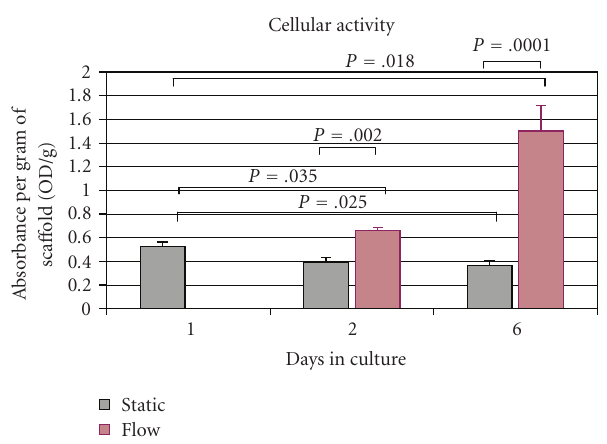
Figure 5: Cellular activity in static and flow-perfusion culture. MTT assay demonstrates no significant change in static culture at day 2. However, metabolic activity increased significantly in cells in flow-perfusion at days 2 and 6. Metabolic activity also significantly decreased in static culture at day